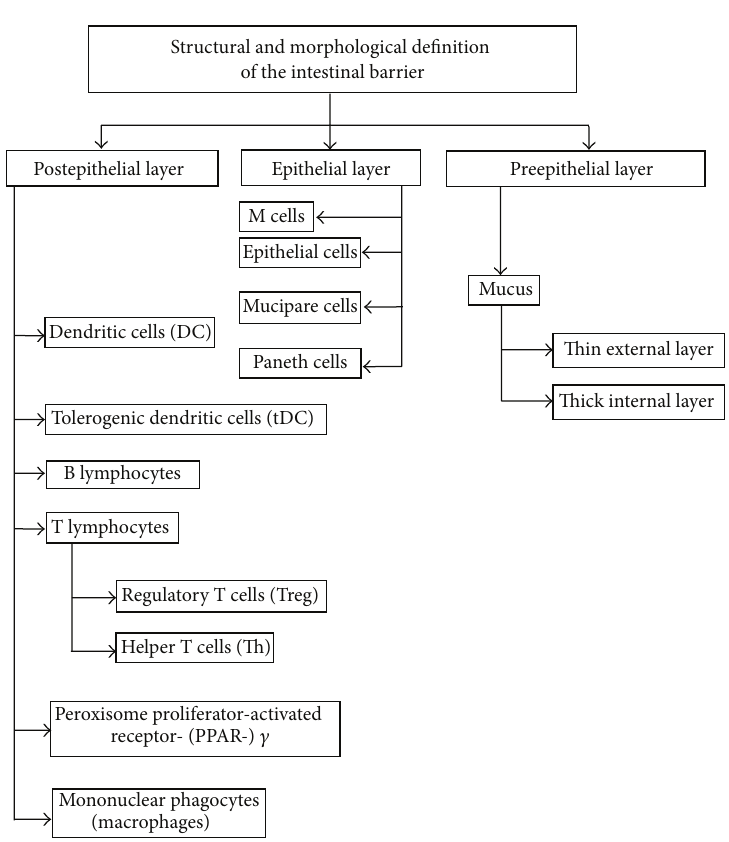
Figure 2: Structural and morphological definition of the intestinal